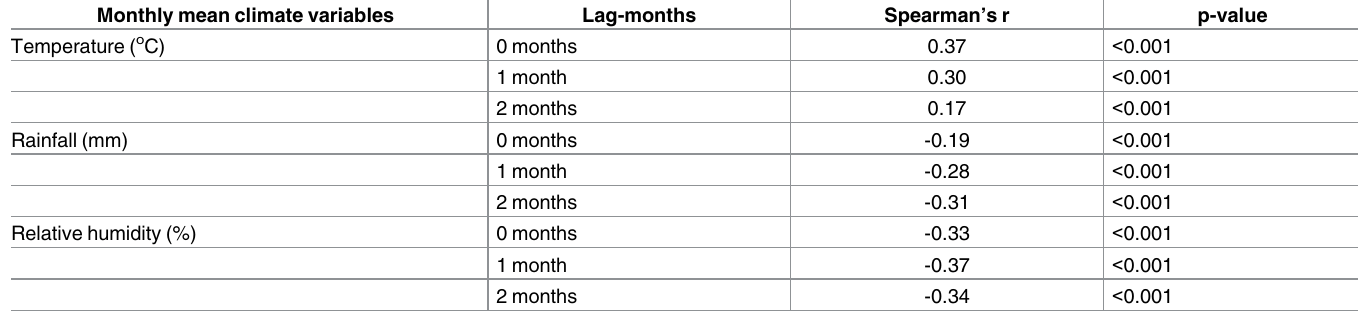
Table 2. Correlation between monthly childhood diarrhea cases and mean monthly climatic variables in northwest Ethiopia, from July 2013 to June